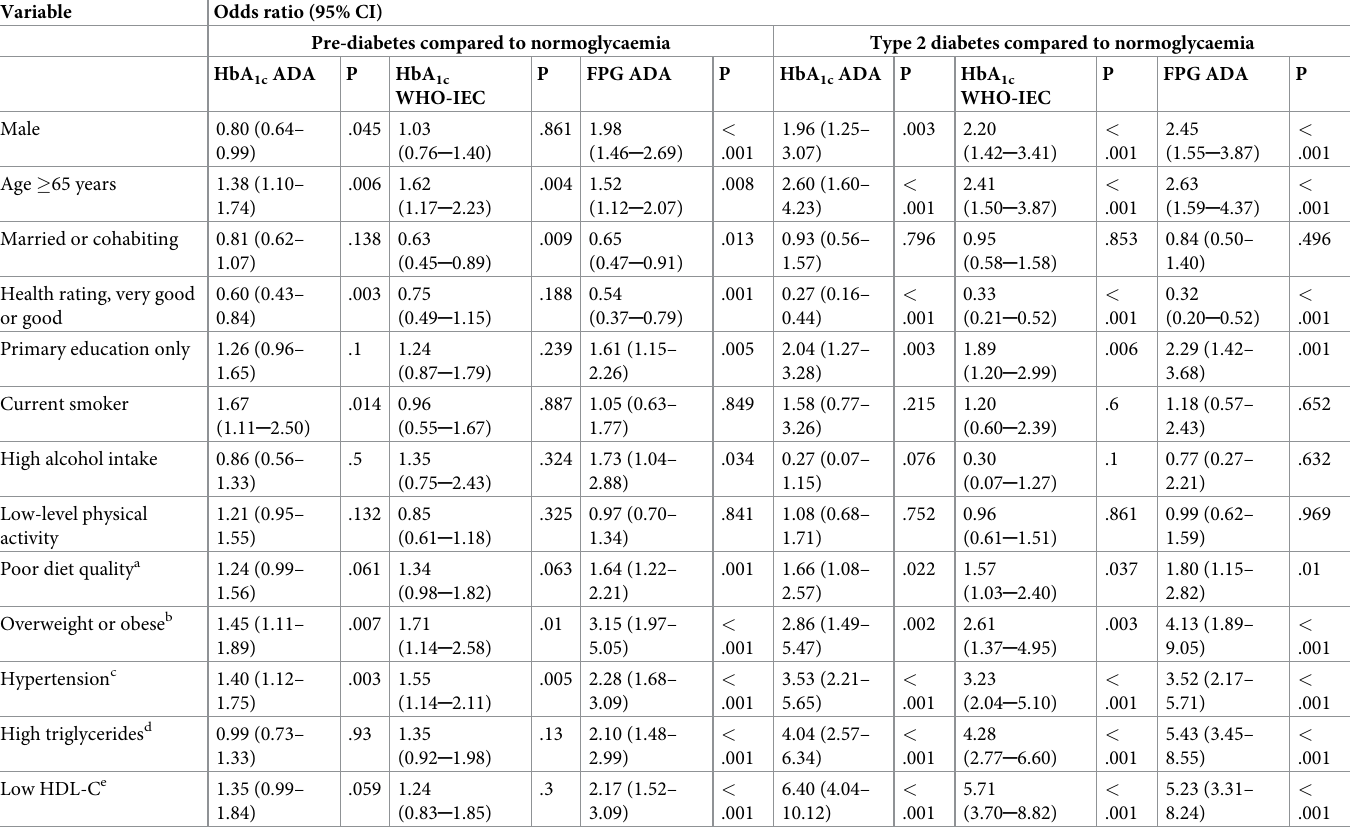
Table 2. Factors associated with pre-diabetes and type 2 diabetes according to diagnosis by HbA 1c or FPG. Variable